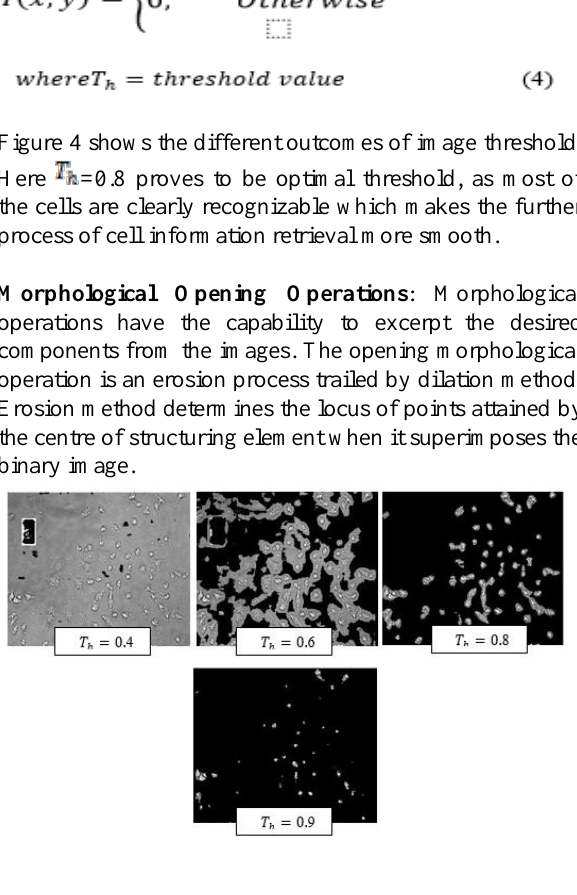
Figure 4. Images illustrating the outcomes after Binarization process with different threshold